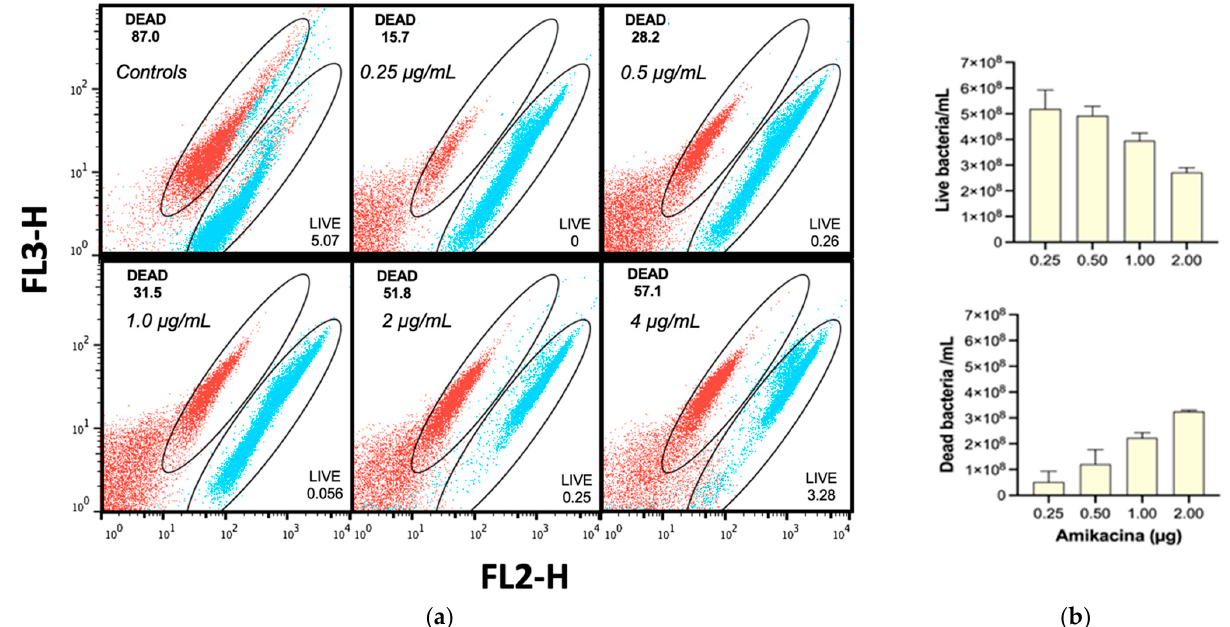
Figure 5. Dot plots of the standardization of live (blue) and dead (red) bacteria on amikacin treatment. ( a ) Representative dot plot of green (FL3-H) vs red (FL2-H) fluorescence of amikacin treatments; ( b ) Bar graphs of the calculated number of live and dead cells for amikacin doses. Bars are expressed as mean ± S.D.